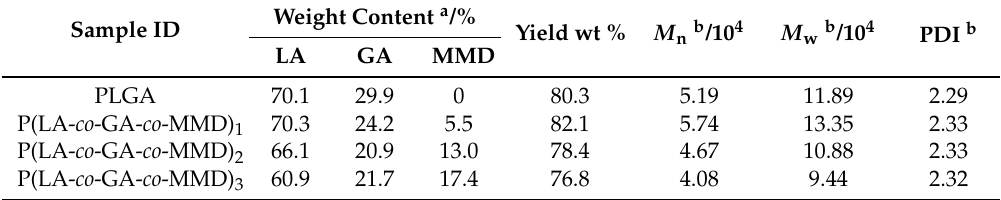
Table 1. The synthesis yields, molecular weights, and contents of LA, GA, and MMD in copolymers. Weight Content a /% Sample ID Yield wt